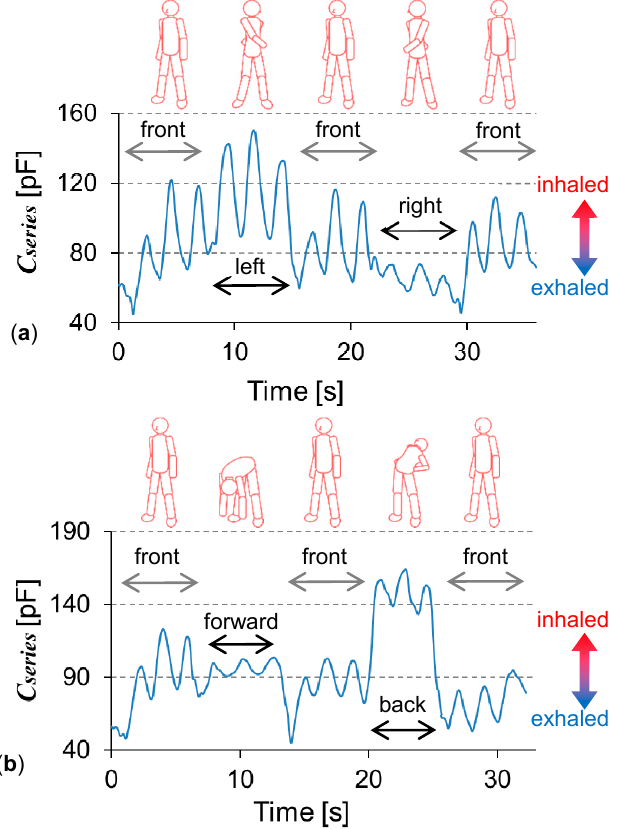
Figure 4. Abdomen capacitance signals during exercise. ( a ) Twisting the upper body left and right. ( b ) Bending the upper body forward and backward. Table 3. Average respiratory rate during exercise (shown in Figure 4). Twisting the upper body left and right.